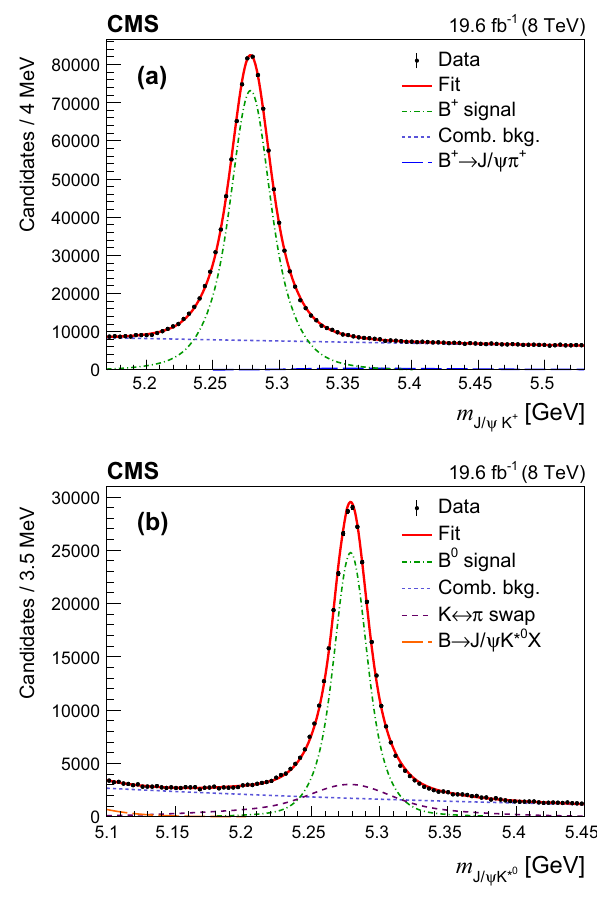
Fig. 1 Invariant mass distributions of a J /ψ K + and b J /ψ K ∗ 0 candi- dates in data with the fit results superimposed. The points represent the data, with the vertical bars giving the corresponding statistical uncer- tainties. The thick curves are results of the fits, the dash-dotted lines display the signal contributions, and the short-dashed lines show the combinatorial background contributions. The long-dashed line shows in a the contribution from the B + → J /ψπ + decay, and in b the contri- bution from partially reconstructed B → J /ψ K ∗ 0 X decays. The dashed line in b displays the contribution from swapping K ± → π ± in the